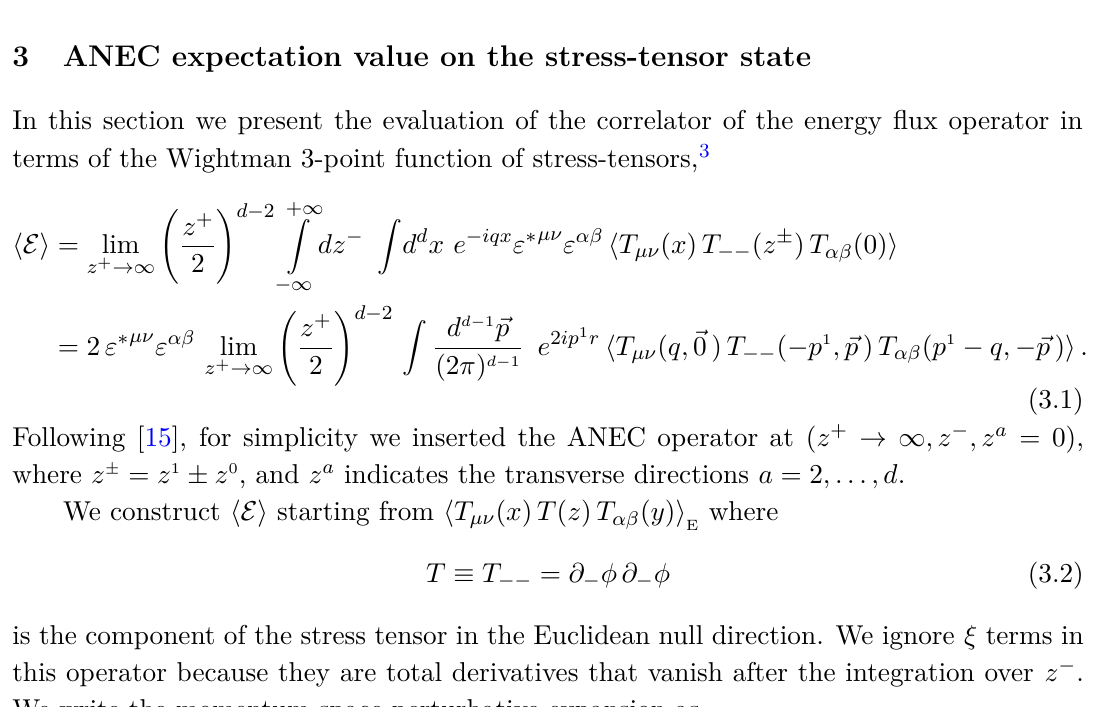
Figure 3 . Diagrams for the 3-point function. We did not include the third permutation of the first order diagram because it does not contribute to the expectation